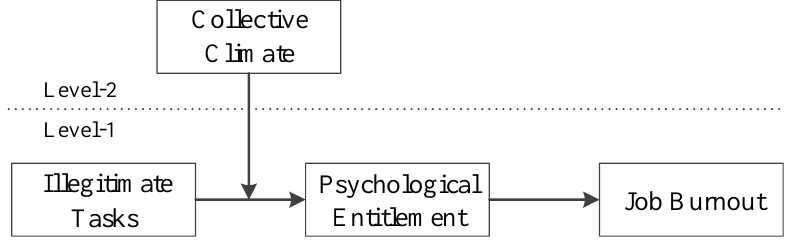
Figure 1. The theoretical conceptual